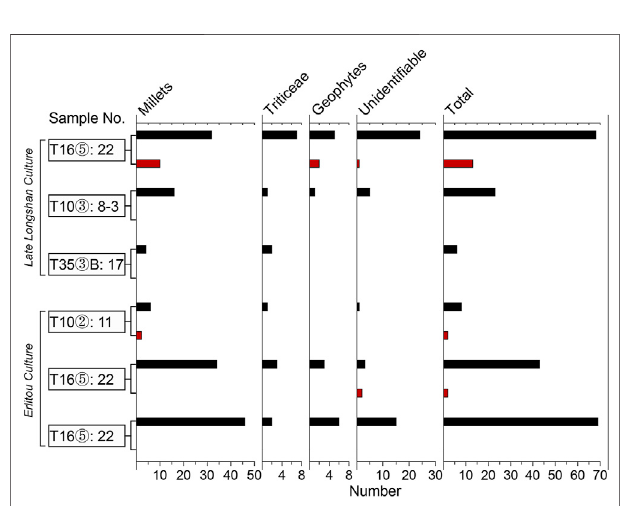
FIGURE 4| Number of starch grains recovered from the residues on the grooved pottery vessels at the Meishan site. Black and red bars represent the samples from the interior face and exterior face, respectively. The results from possible contaminated potsherds have been excluded.